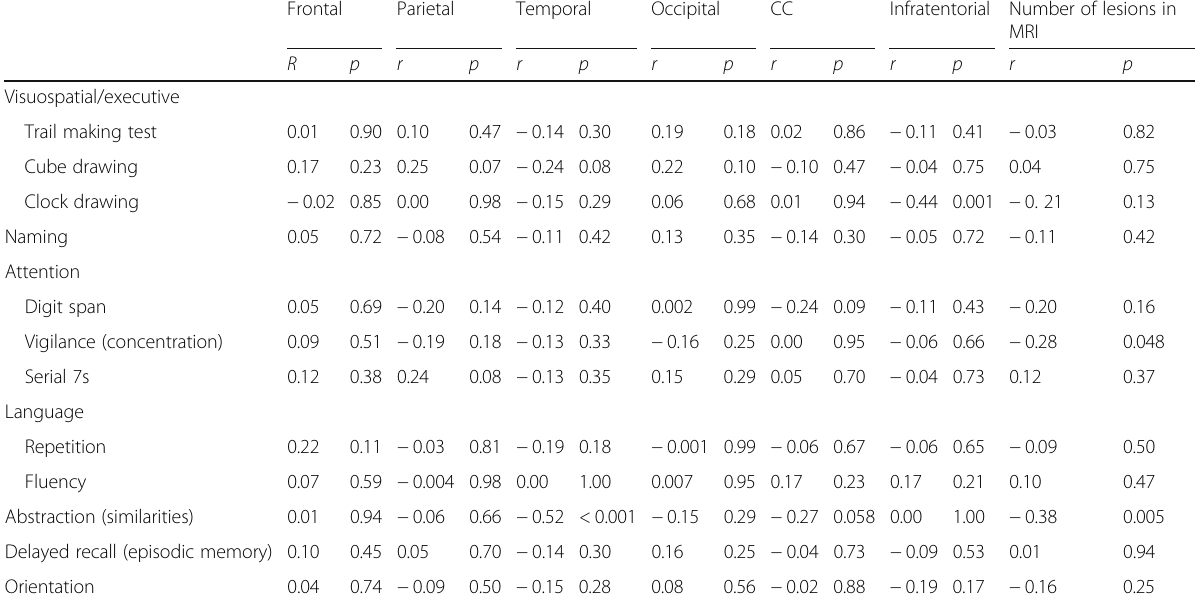
Table 7 Correlation between MRI and the MoCA test Frontal Parietal Temporal Occipital CC Infratentorial Number of lesions in